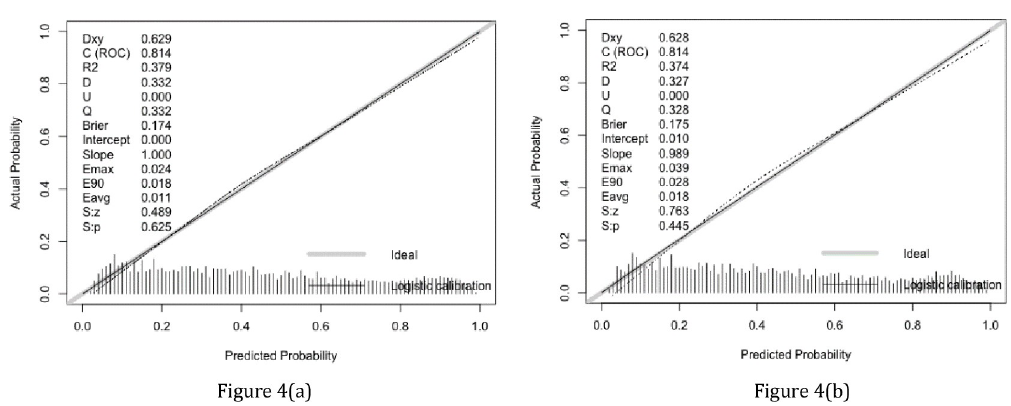
Fig 4. Calibration curves for the prediction and training group models ( p = 0.625 vs 0.445). The diagonal solid line represents a perfect prediction by an ideal model. The dotted line represents the performance of the nomogram, of which a closer fit to the diagonal dotted line represents a better